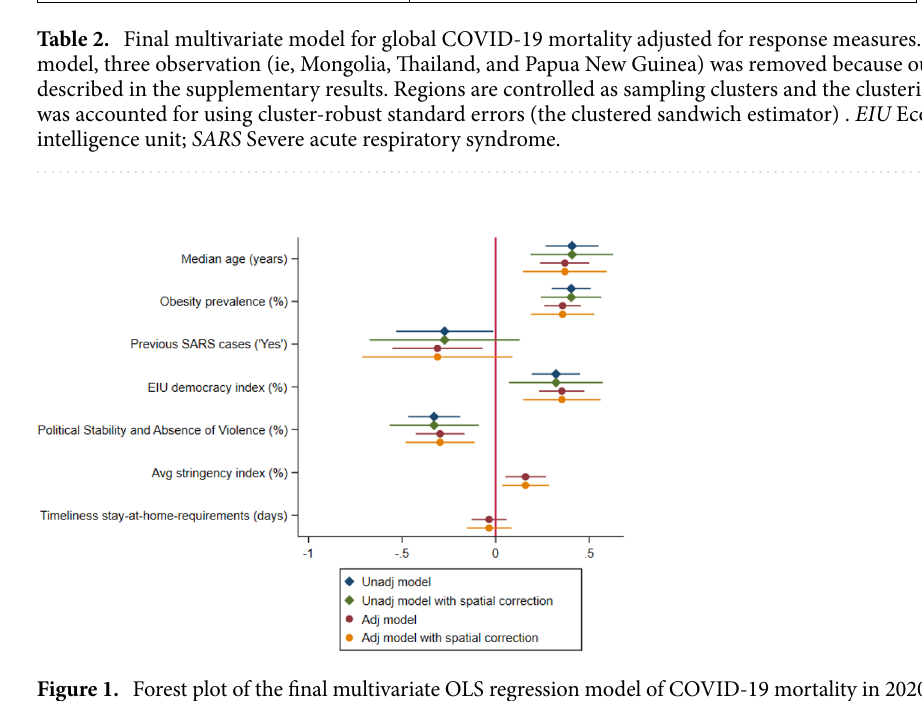
Figure 1. Forest plot of the final multivariate OLS regression model of COVID-19 mortality in 2020 adjusted for response measures, with spatial autocorrelation correction. In the figure, three countries (ie, Mongolia, Thailand, Papua New Guinea) were removed because outliers. Additional information can be found in the supplementary